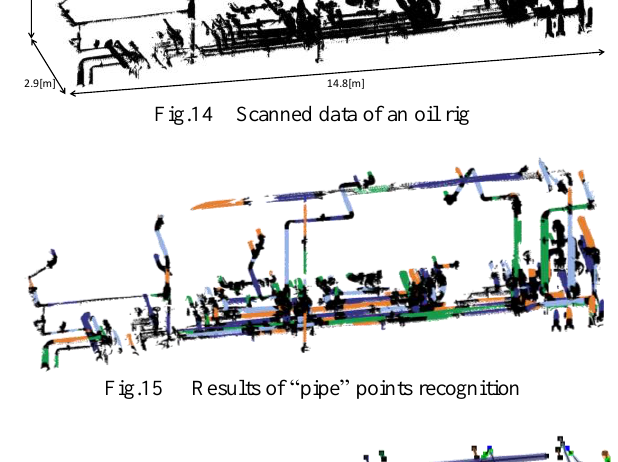
Fig.15 Results of “pipe” points recognition